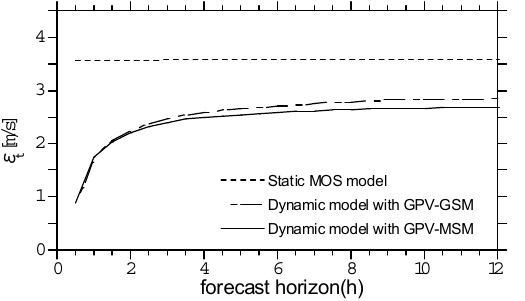
Figure 7. Root mean square error (RMSE) of maximum instantaneous wind speed predicted by the conventional static model output statistics (MOS) and the proposed dynamic models at γ = 0.